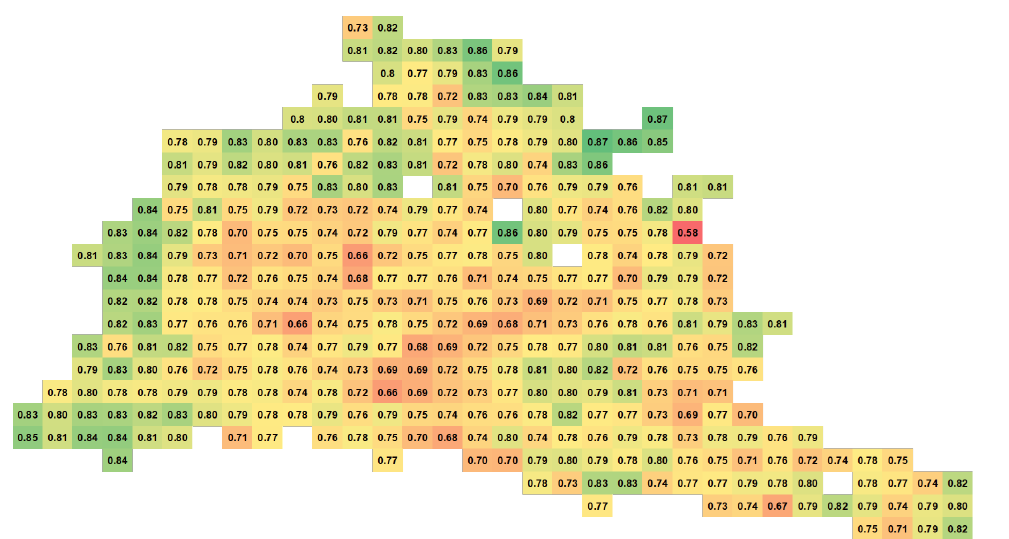
Figure 11. LA spatial analysis of PDR for the entire simulation period. Green cells have high PDR and red cells have low PDR. Yellow cells have in-between